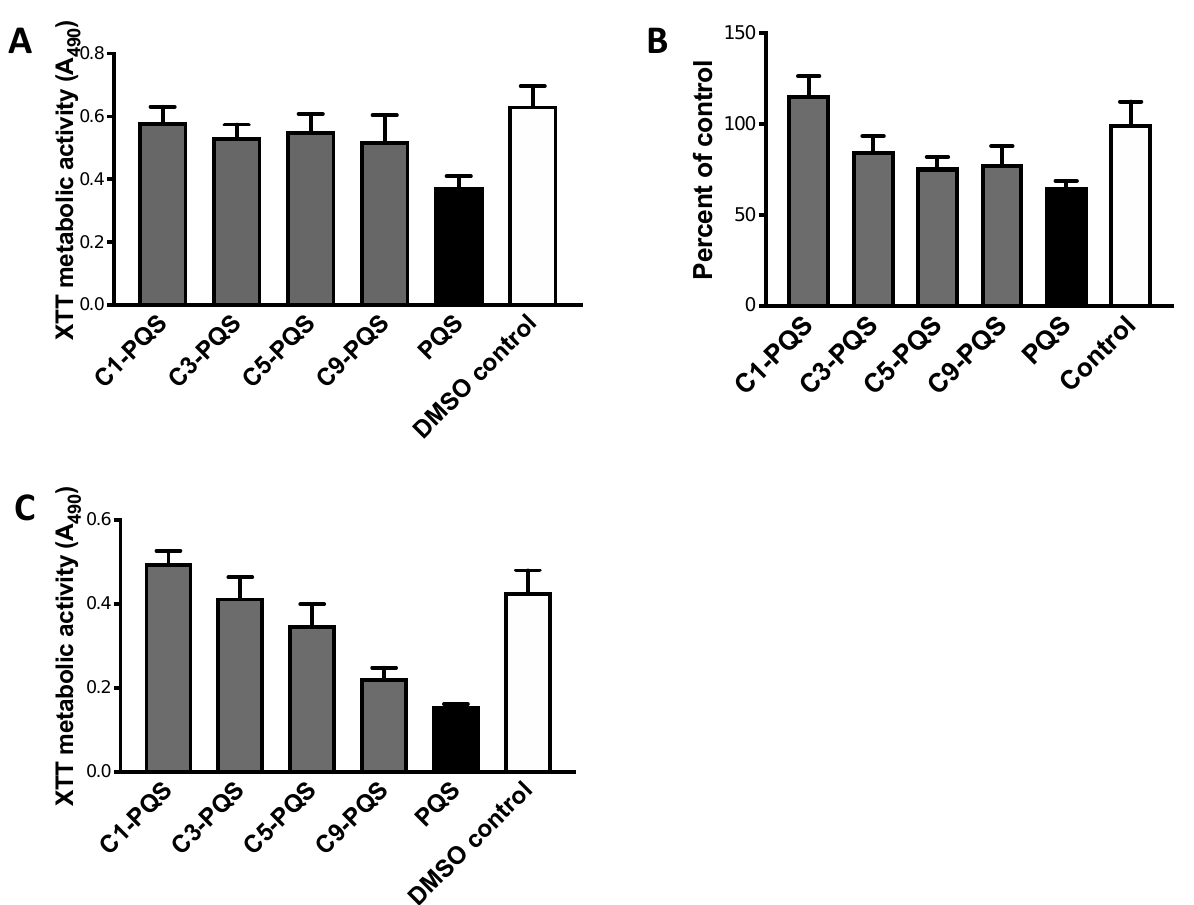
Figure 5. Studies of alkyl side chains on PQS. Comparisons of congeners with PQS. ( A ) Target 10AF, all molecules studied at 12.5 μg/mL. C1-PQS, C3-PQS, C5-PQS, C9-PQS, PQS respectively, are p > 0.05, p < 0.01, p < 0.05, p < 0.05, p < 0.001 compared to control. DMSO control results same as ethanol control shown. C1-PQS, C3-PQS, C5-PQS, C9-PQS are all p < 0.001 compared to PQS. ( B ) Target 10AF, all molecules studied at 1.56 μg/mL; separate plates, so data is referent to controls on each plate. DMSO controls shown, were same as ethanol and RPMI controls. C1-PQS, C3-PQS, C5-PQS, C9-PQS, PQS respectively, are p > 0.05 (actual boost above control), p < 0.01, p < 0.05, p < 0.05, p < 0.001 compared to control. C1-PQS, C3-PQS, C5-PQS, C9-PQS are p < 0.001, p < 0.001, p < 0.01, p < 0.01, respectively, compared to inhibition by PQS. ( C ) Target Af293, all molecules studied at 1.56 μg/mL. Shown are DMSO control same as ethanol control. C1-PQS, C3-PQS, C5-PQS, C9-PQS, PQS respectively, are p > 0.05 (actual boost above control), p > 0.05, p < 0.05, p < 0.001, p < 0.001 respectively, compared to control. C1-PQS, C3-PQS, C5-PQS, C9-PQS are all less inhibitory than PQS ( p < 0.001).